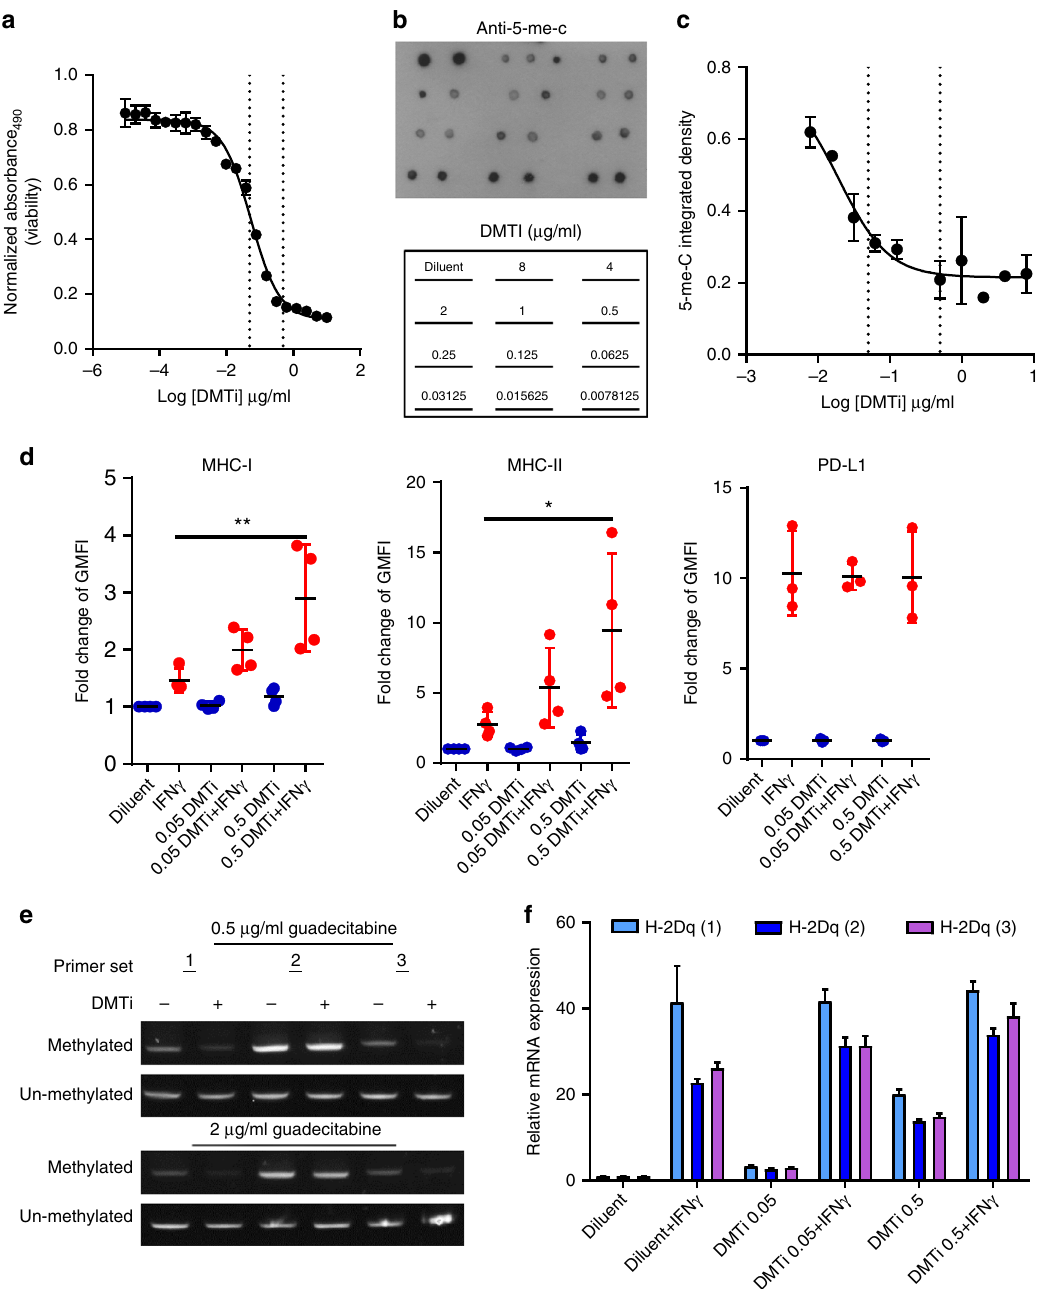
Fig. 2 DMTi treatment augments MHC-I and MHC-II, but not PD-L1 expression on the cell surface upon IFN γ stimulation. a Viability assay of MMTV-Neu cells under guadecitabine (DMTi) treatment. All data are means ± SD. Dotted lines represent doses used in subsequent studies (0.5 and 0.05ug/mL). b Representative anti-5-mC dot blot of DNA isolated from MMTV-Neu cells under different concentrations ( µ g/ml; blot map in lower panel) of DMTi treatment. c Quanti fi cation of ( b ) based on integrated density of each dot. All data are means ± SD. d Fold change of GMFI of MHC-I, MHC-II and PD-L1 in MMTV-Neu cell line with guadecitabine treatment + IFN γ stimulation. GMFI ratio of diluent group was used as the baseline. * p < 0.05; ** p < 0.01 (one-way ANOVA with Tukey ’ s post-hoc test). All data are mean ± SEM. Each data point represents one independent experimental result. e Methylation-speci fi c PCR for CpG-rich region of the H-2D q promoter in MMTV-neu cells. Genomic DNA isolated from cells 7 days after treatment with 0.5 µ g/mL or 2 µ g/mL guadecitabine were bisul fi te-treated and analyzed by PCR using paired PCR primers speci fi c for modi fi ed (methylated) and unmodi fi ed (unmethylated) cytosines. f Quantitative real-time PCR using three primer sets targeting mRNA expression of the H-2D q allele of MMTV-neu cells after 7 days after treatment with 0.05 µ g/mL or 0.5 µ g/mL guadecitabine or diluent control and with or without 24 h of stimulation with IFN γ (100